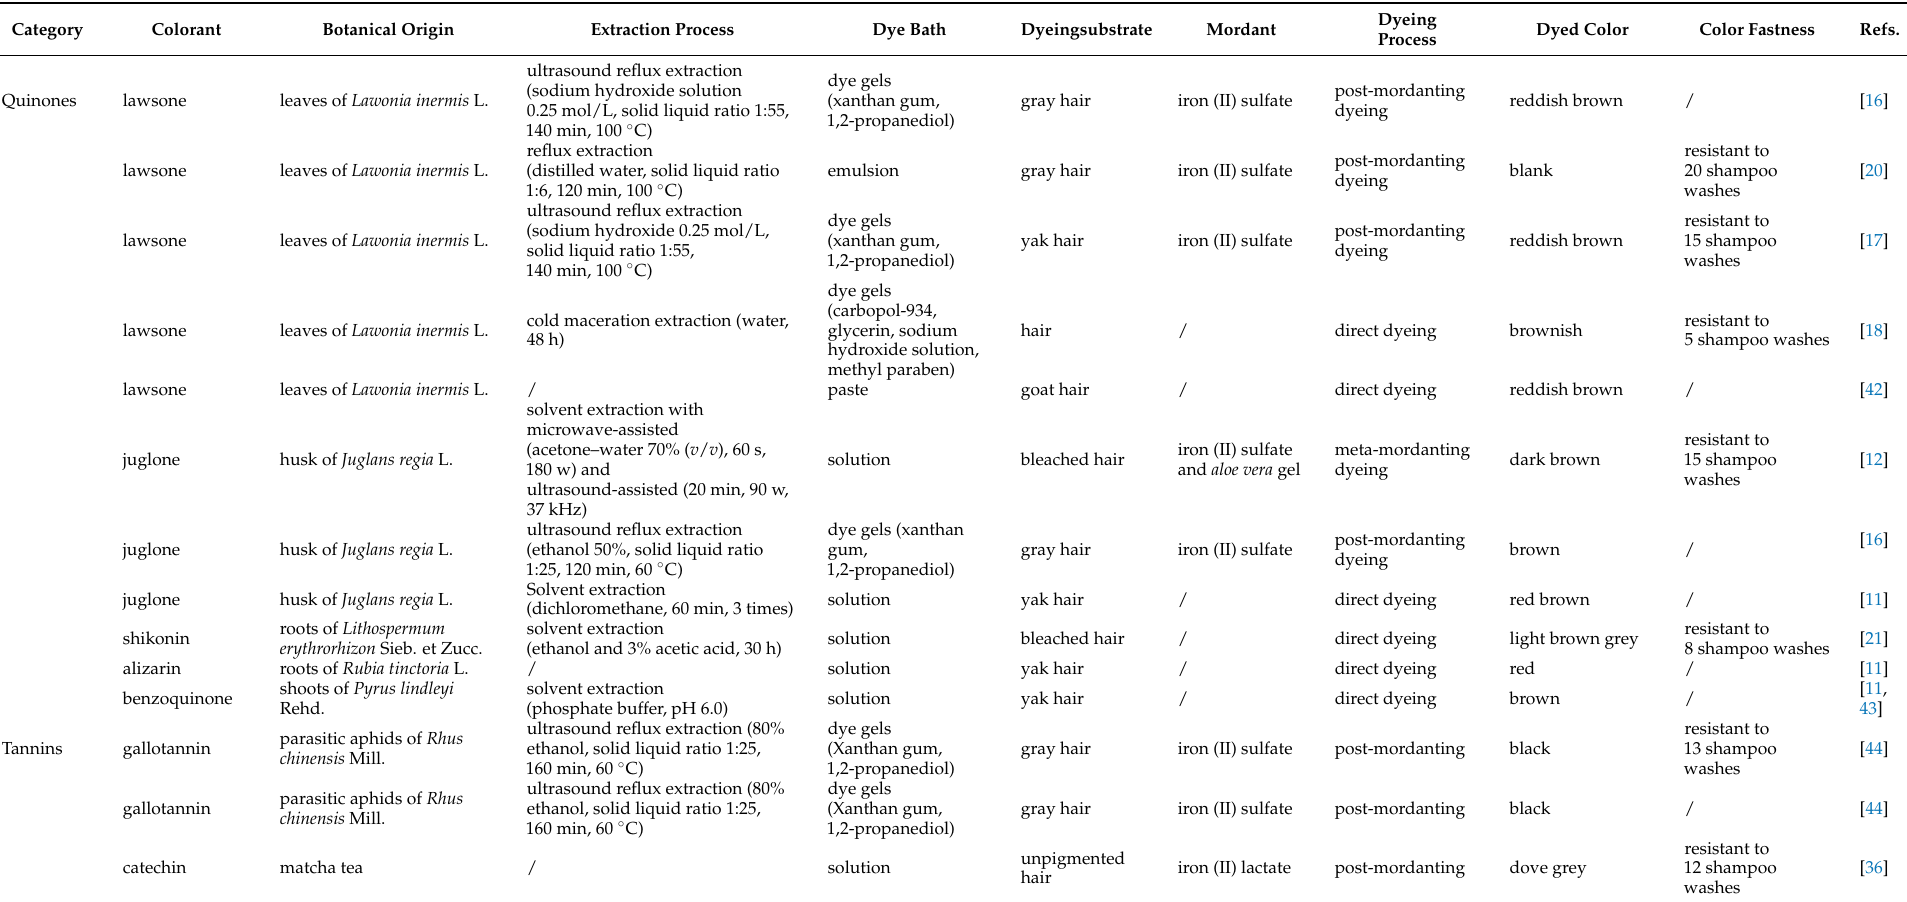
Table 1. Summary of natural plant colorants used for hair dye